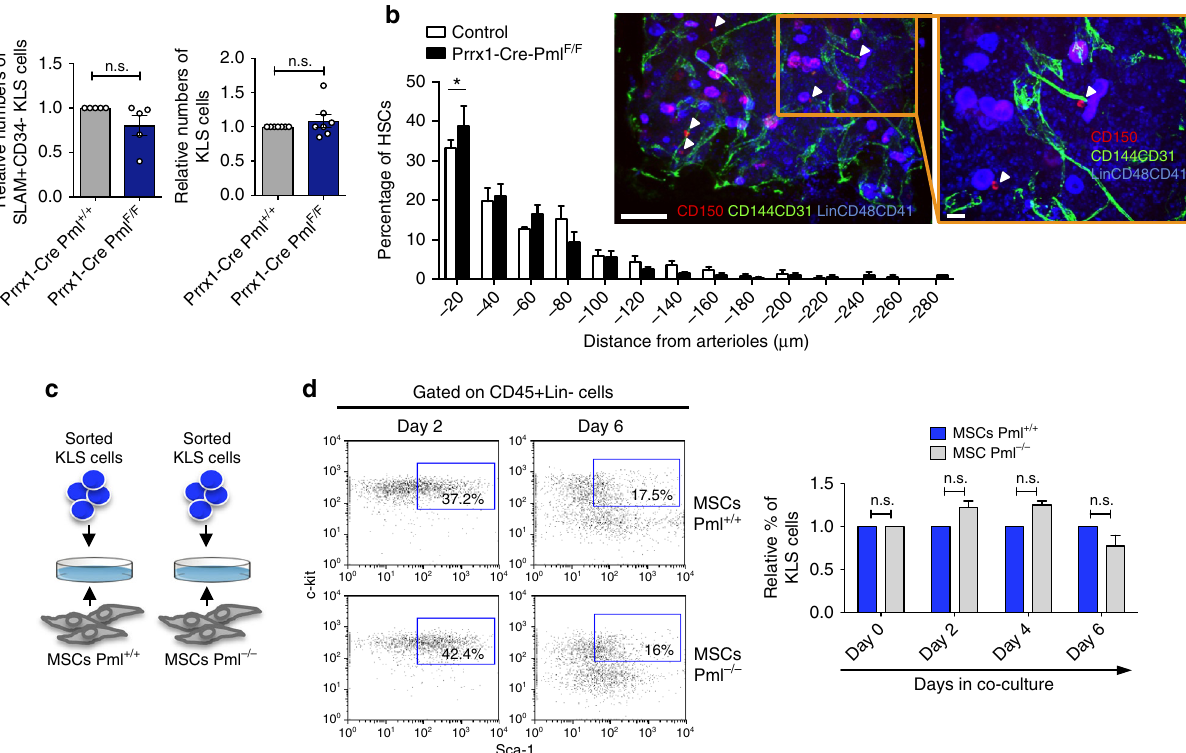
Fig. 2 Pml regulates only marginally HSCs in a non-cell-autonomous manner. a Flow-cytometry analysis of the HSCs compartment of Prrx1-Cre-Pml + / + and Prrx1-Cre-Pml F /F mice. SLAM + CD34 − KLS cells are shown on the left panel, while KLS cells are shown in the panel on the right ( n ≥ 5 mice analyzed). Error bars represent the mean ± SEM. b Localization of HSCs relative to arterioles in the sternal bone marrow. n = 203,219 HSCs from three mice per control and Prx1-cre + group, respectively. Distance between HSCs and arterioles was measured blindly for genotype. Two-sample Kolmogorov – Sminov test; P = 0.05. Error bars represent the mean ± SEM. Representative whole-mount images of sternal bone marrow are shown on the right. Arrowheads denote Lin − CD48 − CD41 − CD150 + phenotypic HSCs. Scale bars indicate 100 μ m in original image and 20 μ m in inset. Vascular endothelial cells are stained with anti-CD31 and anti-CD144 antibodies. c Schematic representation of the co-culture assays between MSCs and sorted KLS cells. d Co-culture assays between MSCs ( Pml +/+ or Pml − / − ) and freshly isolated KLS cells. The representative plots on the left panel show the percentage of KLS cells at day 2 or day 4 of the co- cultures. The chart on the right shows the relative percentage of KLS cells in co-cultures with MSCs Pml +/+ or Pml − / − at different days. Chart shows one representative experiment ± SEM out of three independent